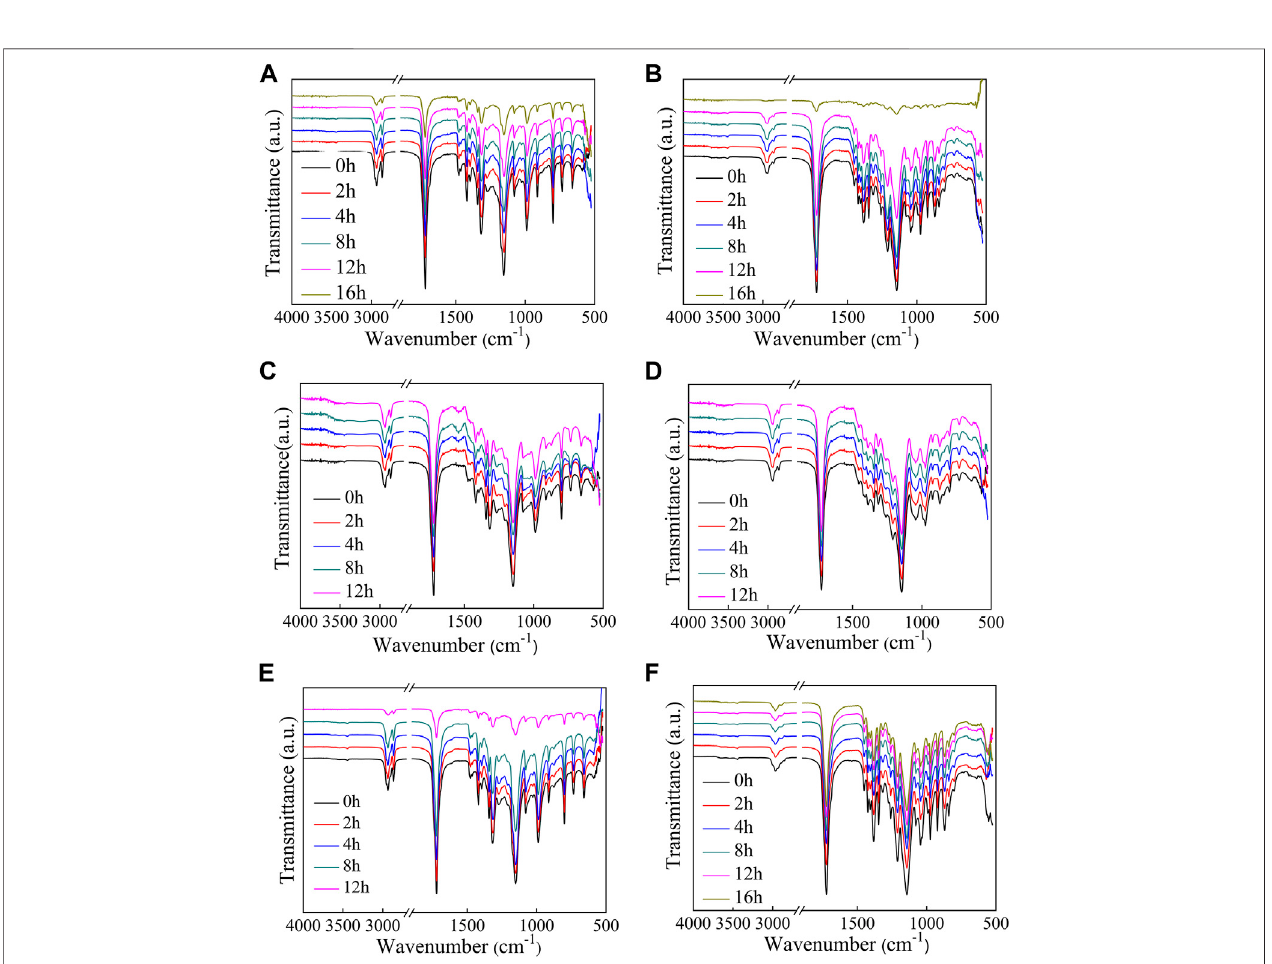
Frontiers in Bioengineering and Biotechnology |